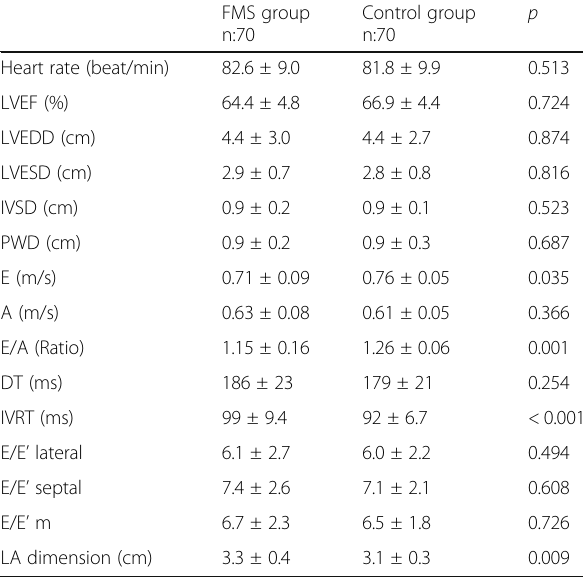
Table 2 Conventional echocardiographic and tissue Doppler echocardiographic parameters of the FMS and control groups